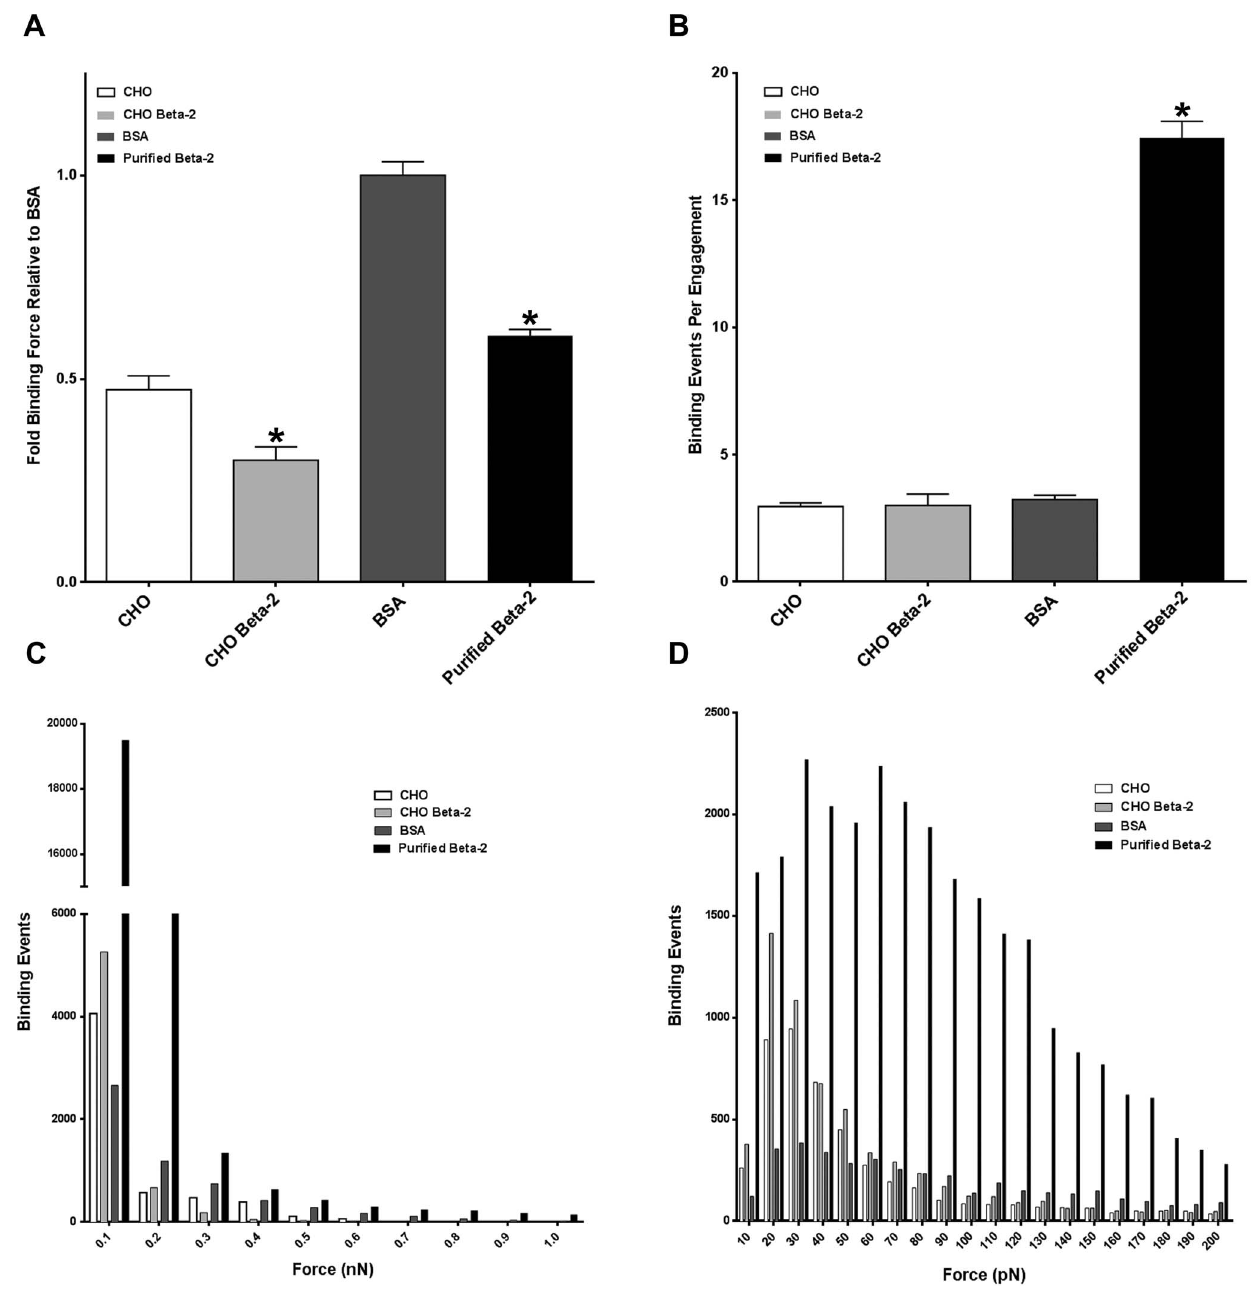
Figure 8. An AFM tip coated with either serum-free CHO cell conditioned media (CHO), serum-free CHO conditioned media containing beta-2 myc-His ectodomain (CHO Beta-2), 100 m g/mL BSA (BSA), or 100 m g/mL purified beta-2 myc-His ectodomain (Purified beta-2) was engaged to a 60 mm plate coated with 50 m g/mL laminin. CHO Beta-2 exhibits a statistically significant reduction in binding force ( A , P , 0.05) relative to control CHO but generates a slight increase average binding events ( B ) and force distribution ( C,D ) when engaged to a laminin-coated dish. Purified beta-2 displays a 40% decrease in binding force relative to BSA ( A ) but elicits a significant increase in average binding events per engagement ( B ) and a more extensive force distribution ( C,D ) than BSA. Specifically, purified beta-2 elicits a significant increase in binding events between 10–200 pN compared to BSA ( D ). Fold binding force data presented as fold relative to BSA 6 normalized SEM